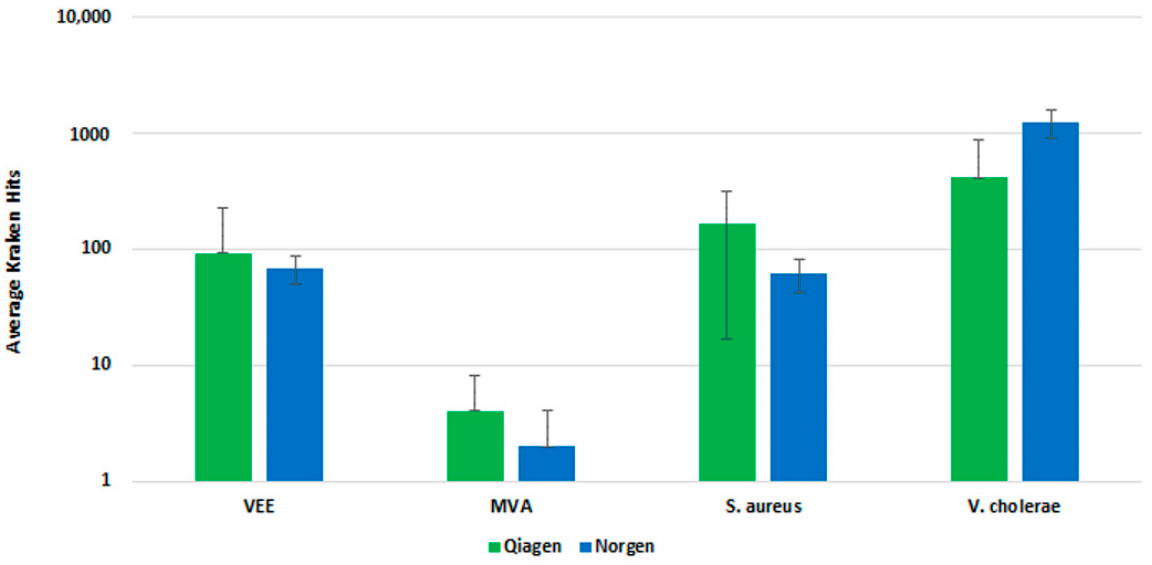
Figure 5. Clinical Extraction Kit Comparison. This figure illustrates the average number of Kraken hits for n = 3 replicate extraction reactions with the Qiagen and Norgen extraction kits.